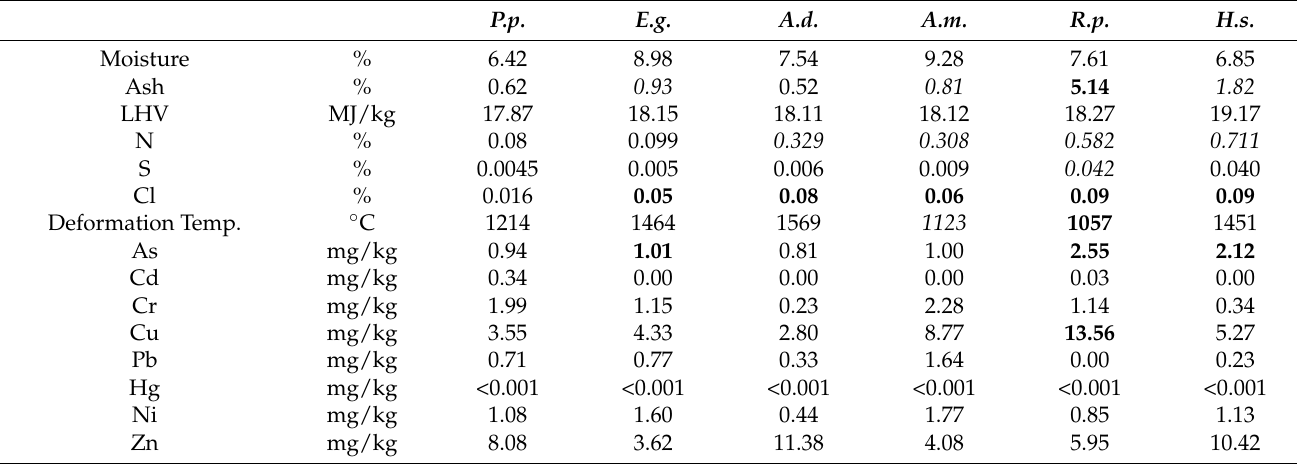
Table 2. Comparative analysis of the results obtained with the parameters defined by the ENplus ®